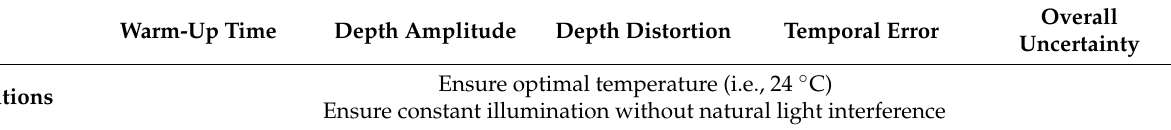
Table 2. Summary of the proposed ToF camera evaluation